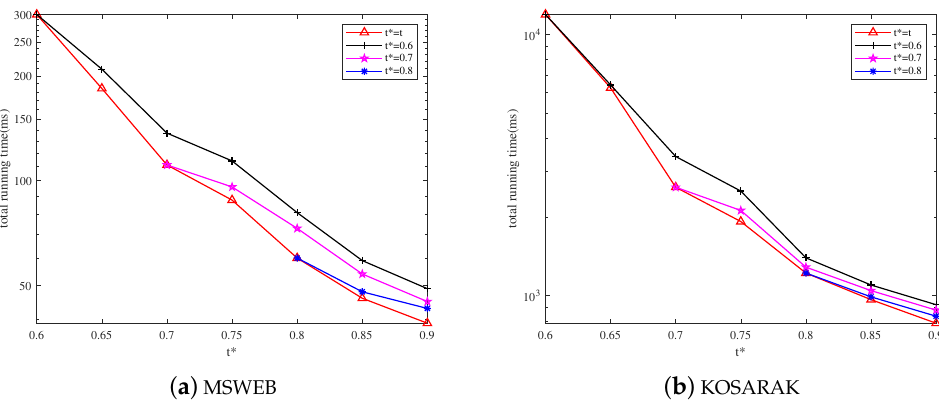
Figure 7. The results for supporting different query